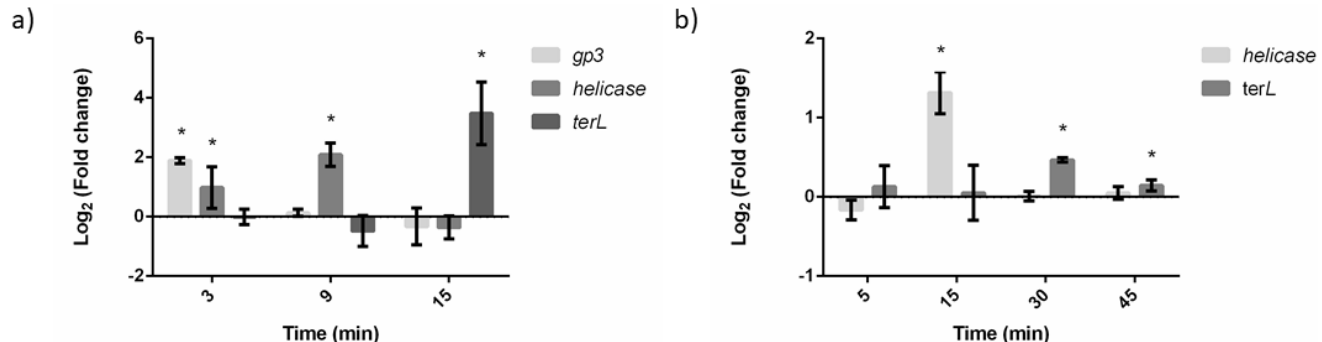
Figure 3. Gene expression of phage PE3 ( a ) and phage DP1 ( b ) after P. aeruginosa PAO1 infection with a MOI of 50 at different time points. The quantification of mRNA transcripts was determined using a variation of the Livak method (E ΔCt ), with 16S rRNA as a reference gene and non-infected cells as a control. The values represent the mean plus or minus standard deviation of two independent experiments performed in triplicate. Statistical differences (* p < 0.05) were analyzed using ANOVA with Tukey’s honest significant difference post hoc test.